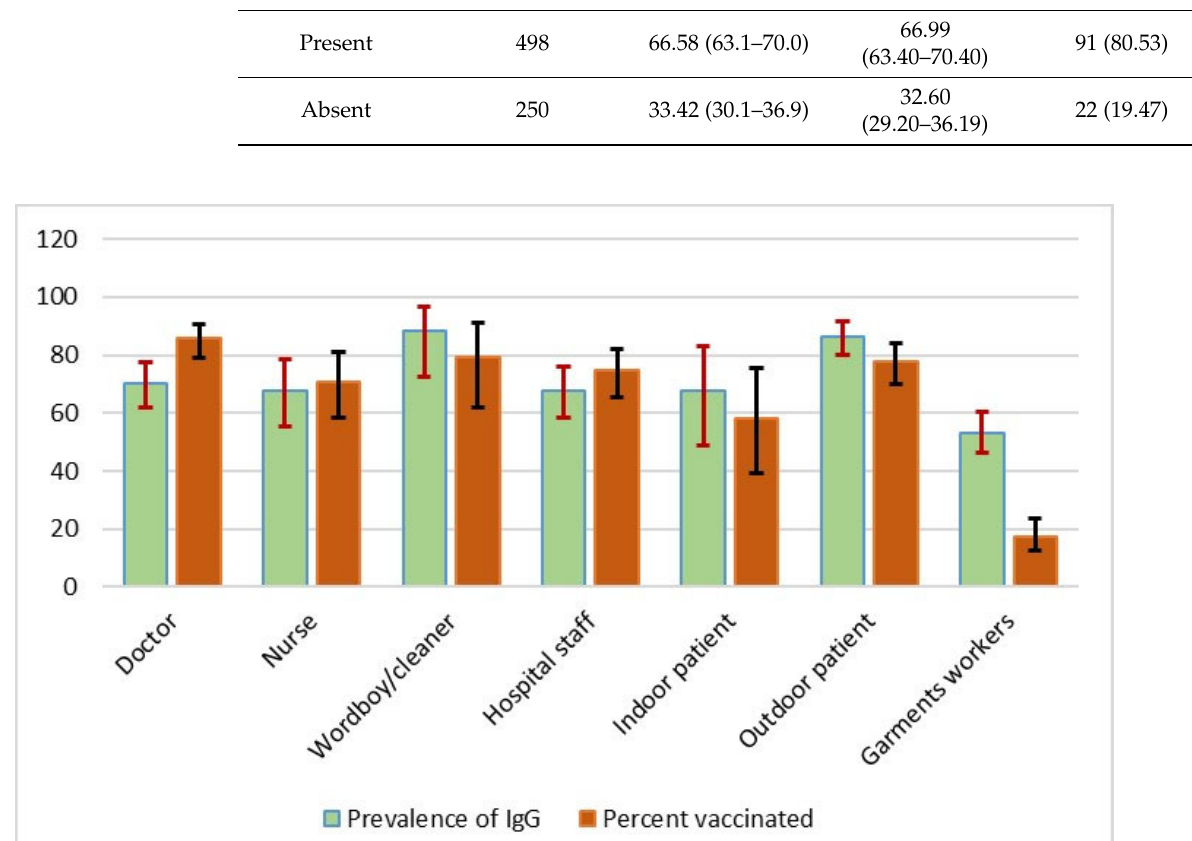
Table 1. Prevalence estimation in CMA.